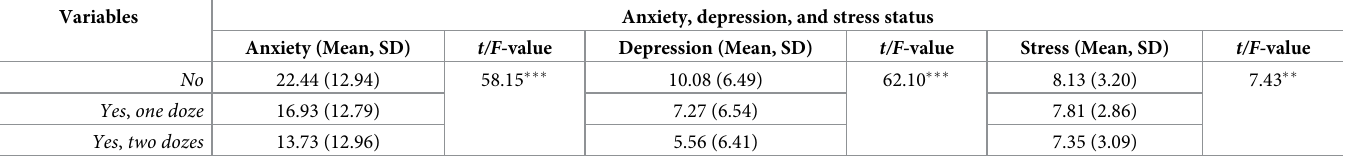
Surprisingly, recovered COVID-19 patients did not differ from the non-infected partici- pants in any outcome measures. Nonetheless, participants who had family members tested positive were more vulnerable in terms of anxiety ( t = -2.66, p = .007, d = 0.12) and depres- sion ( t = -4.01, p < .0001, d = 0.19) than those whose family members remained unaffected. The difference in stress between these two groups did not reach statistical significance ( p = .065). The mental health outcomes of participants who were not vaccinated and took single and double doses differed significantly. For example, compared to participants without vaccina- tion, participants with a double dose had significantly lower anxiety ( Mean difference = 8.72, p < .0001), depression ( Mean difference = 5.52, p < .0001), and stress ( Mean difference = 0.78, p < .0001). Similarly, compared to participants without vaccination, participants with single- dose vaccination also had significantly lower anxiety ( Mean difference = 5.51, p = .004) and depression ( Mean difference = 2.81, p = .003). However, the single-dose vaccination did not impact perceived stress ( p = .731). Those who had a single dose and double doses were not dif- ferent in any mental health outcomes.